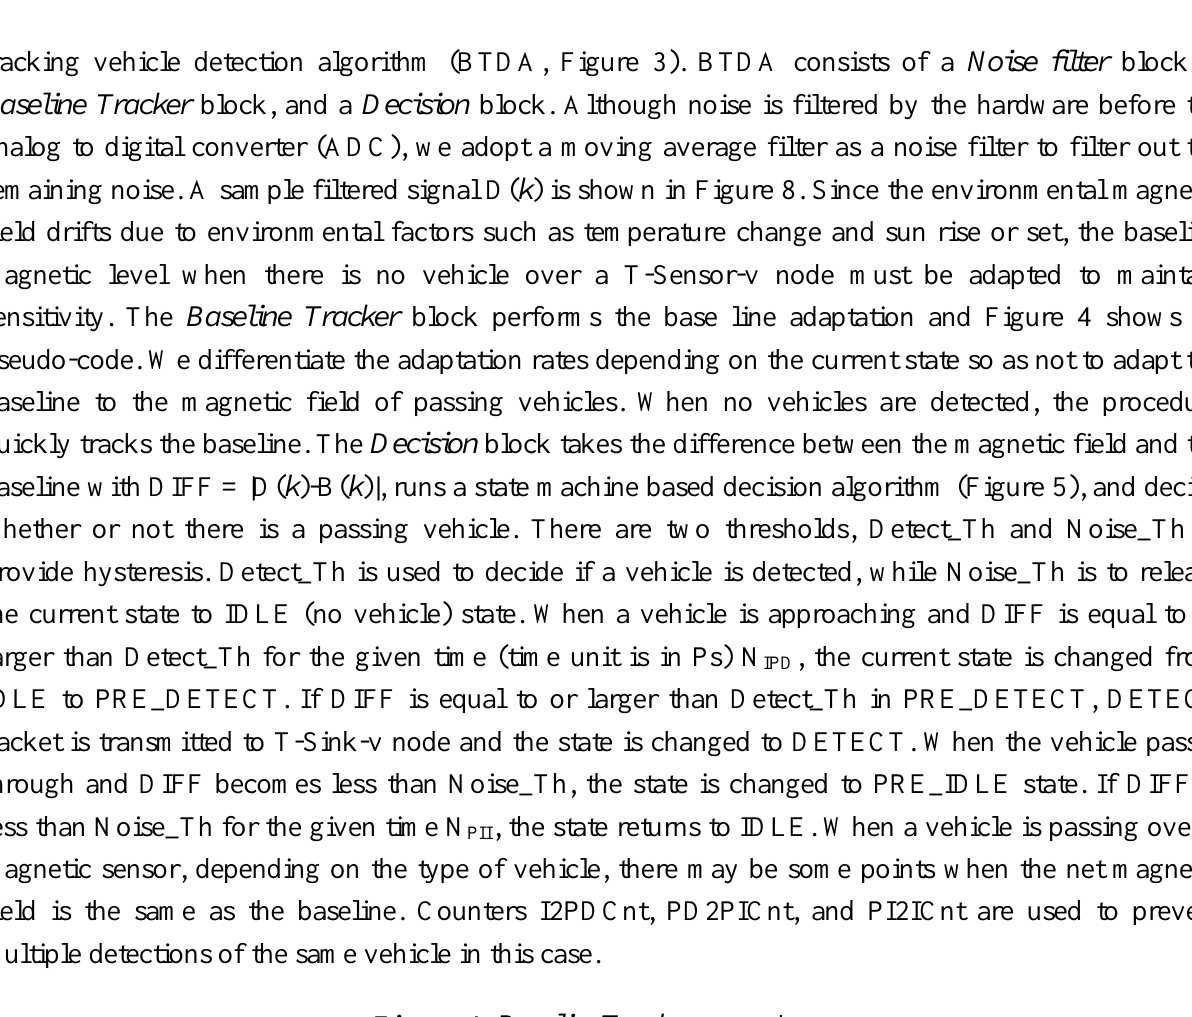
Figure 4. BaselineTracker